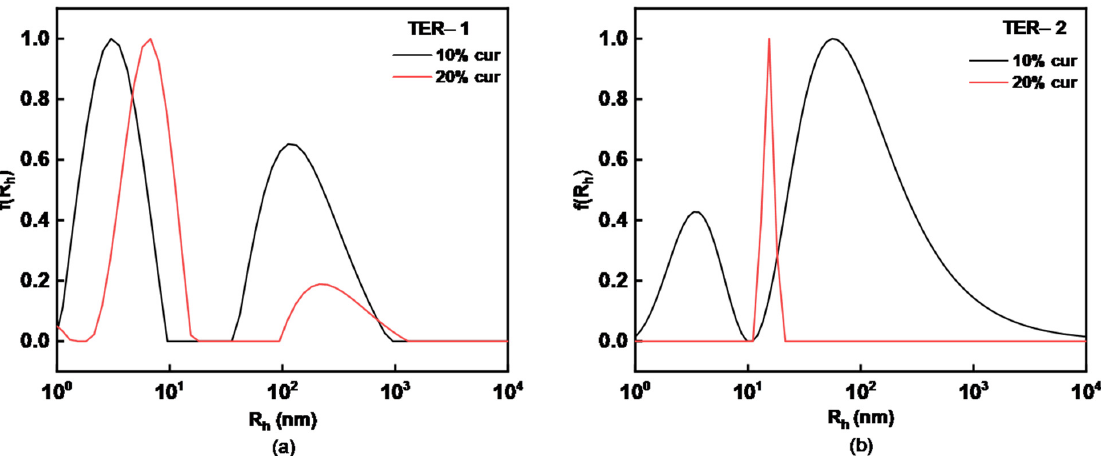
Figure 10. ( a ) TER-1 and ( b ) TER-2 terpolymer mixed aggregates with curcumin encapsulation 10% w / w and 20% w / w from thin-film protocol. Table 4. DLS results before and after curcumin encapsulation in P(DMAEMA-co-LMA-co-OEGMA)